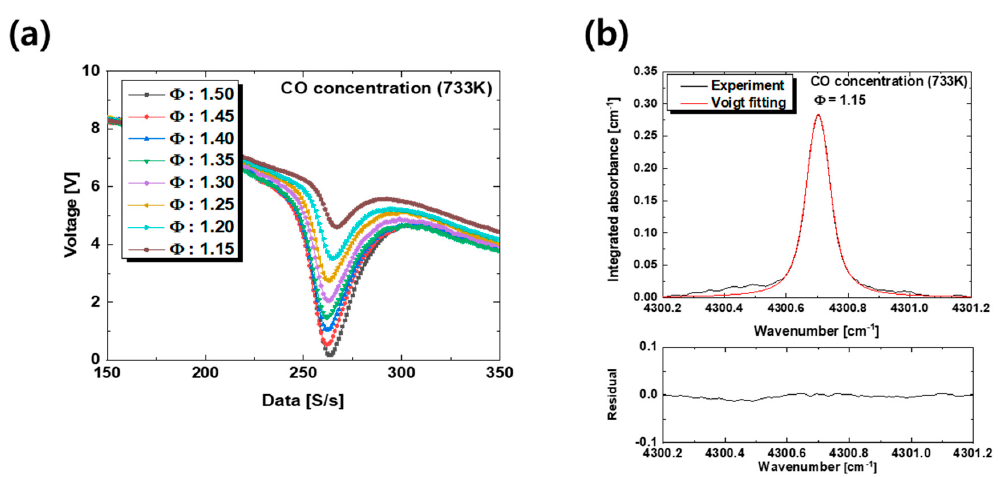
Figure 5. ( a ) Measured CO absorption signal at 733 K under the conditions of the equivalence ratio in the combustion environment. ( b ) Voigt profile for experimental data at the equivalence ratio of 1.15.